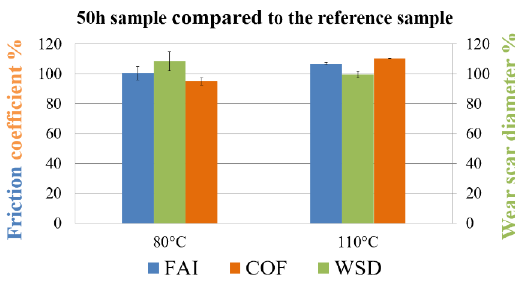
Figure 9. The tribological results of oil sample number 2, compared to the ÖMV 20W50 reference engine oil (figure of the authors)